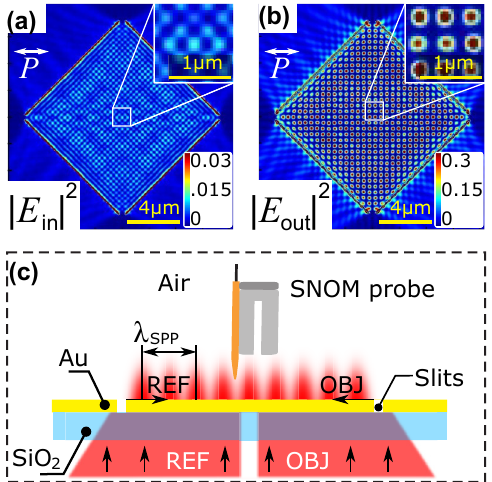
Figure 1: Numerical calculations of near field and scheme of the measuring method. (a) and (b) Calculated distribution of the normalized near-field intensity on the square SPID: (a) in-plane electric and (b) out-of-plane electric component. Polarization of the illumination is indicated with the white arrow. Insets show details of the field distribution in the centre of the SPID. (c) A scheme of the SPID with the illumination wave, the near-field object (OBJ) and reference (REF) waves, and an SNOM